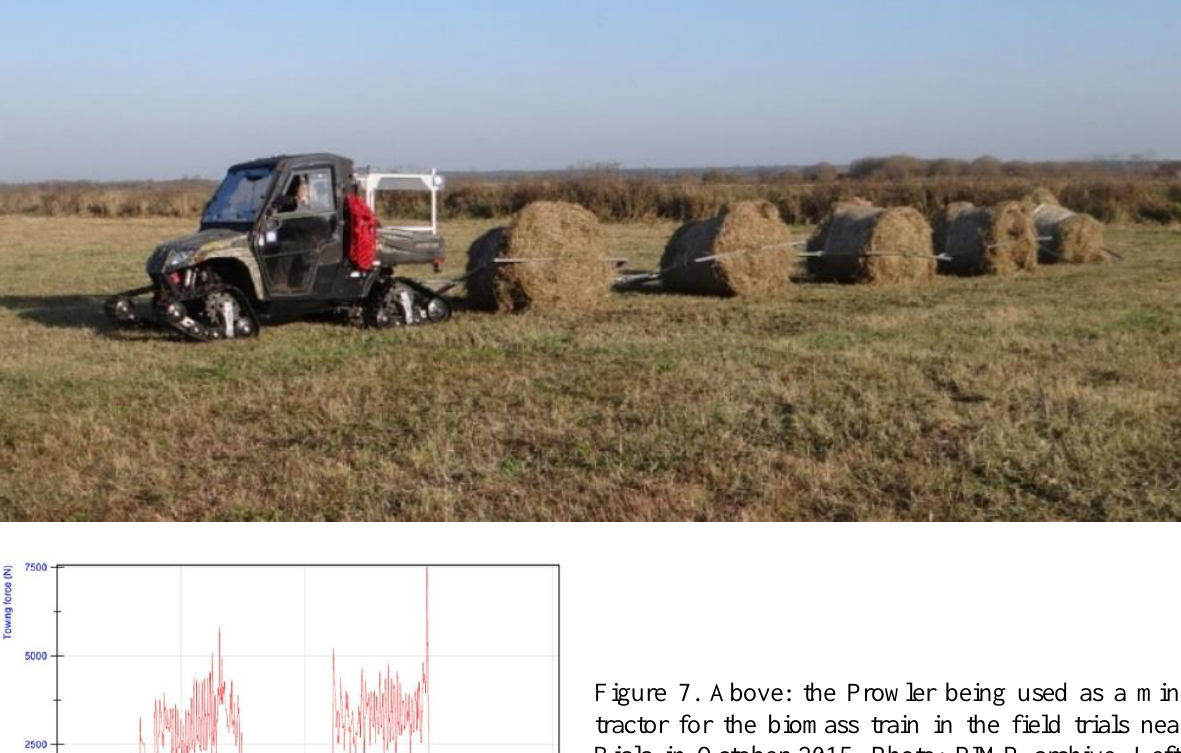
Figure 7. Above: the Prowler being used as a mini tractor for the biomass train in the field trials near Biala in October 2015. Photo: PIMR archive. Left: The forces on the clevis pin hitch when towing five biomass bales during the October 2015 field trials (NI